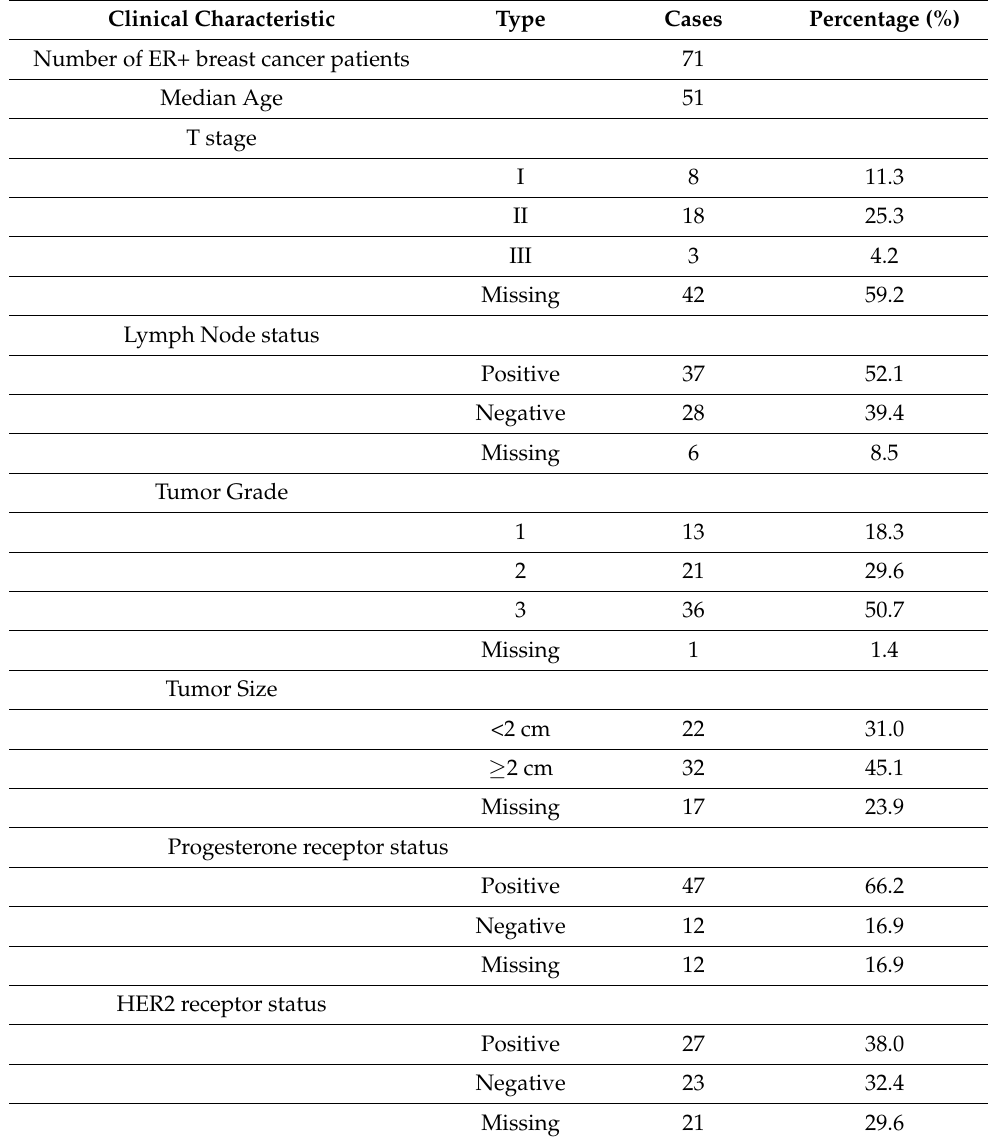
Table 2. Clinical characterization of ER+ breast cancer patients in the current